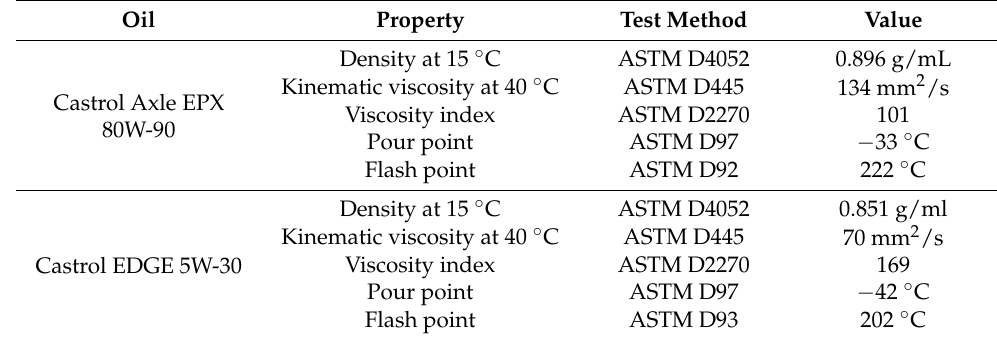
Table 3. Basic physico-chemical properties of the oils.